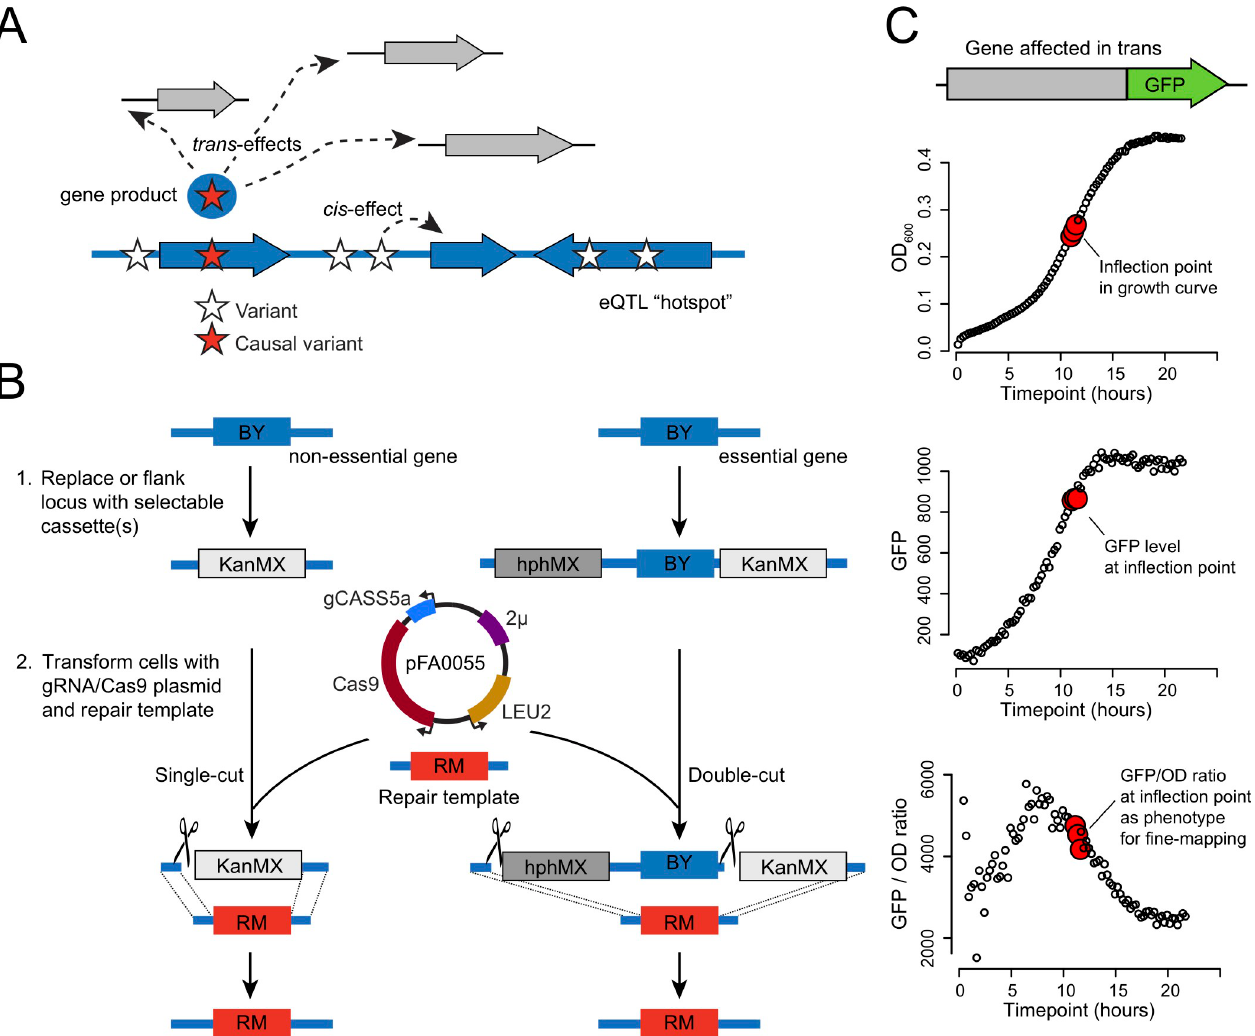
Fig 1. Hotspot fine mapping strategy. A. Illustration of the possible cis and trans effects at an eQTL hotspot. A genomic region, shown in blue with several genes depicted as wide arrows, harbors multiple variants (stars). Of these, one causal variant (red star) alters the activity and/or abundance of a gene product (blue circle with red star), which alters the expression of multiple genes (gray arrows) in trans . Another variant is shown affecting a neighboring gene in cis , but has no trans effect. B. A schematic showing two examples of engineering a BY allele (blue) to an RM allele (red) using CRISPR-Swap. First, a non-essential gene is replaced by the G418 resistance cassette (KanMX) or an essential gene is flanked by the hygromycin resistance (hphMX) and KanMX cassettes. Second, the strain is transformed with the CRISPR-Swap plasmid pFA0055 that expresses Cas9 and the guide RNA gCASS5a and the auxotrophic marker LEU2; and a PCR-generated repair template containing the desired RM allele. The gCASS5a/Cas9 complex directs cleavage (scissors) of the cassettes. Either a single-cut or a double-cut occurs depending on the number of cassettes present. Selection of transformants for leucine prototrophy and loss of G418, or hygromycin and G418, resistance identifies strains with the desired RM allele replacement. C. Quantifying the expression of a representative gene affected in trans by a hotspot. Fluorescence of the protein expressed from the GFP-tagged gene and optical density (OD 600 ) of the culture are measured in 15 minute intervals during growth in a plate reader. The inflection point, the point where the culture exits logarithmic growth, and two flanking points are used to determine the GFP/OD 600 ratio for phenotyping the effect of the engineered alleles.